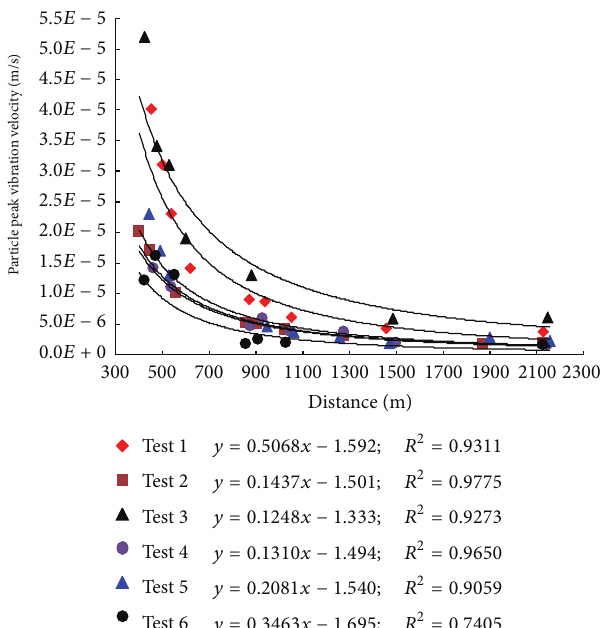
Figure 5: Particle peak vibration velocity damping law of Test 1.